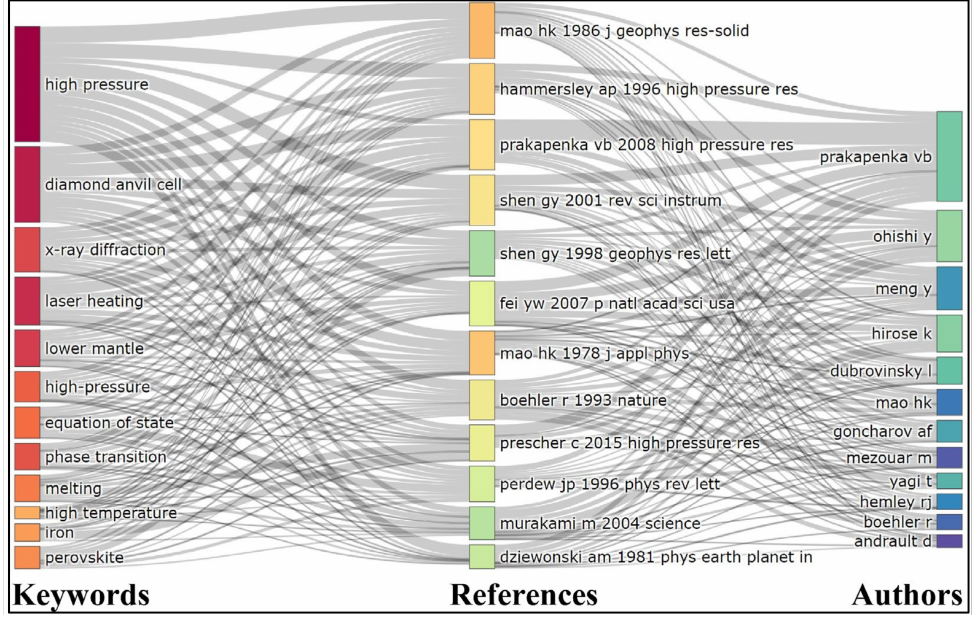
Figure 2. Three-field diagram showing relationships between the 12 most-cited authors, articles and keywords of the L-DACs works